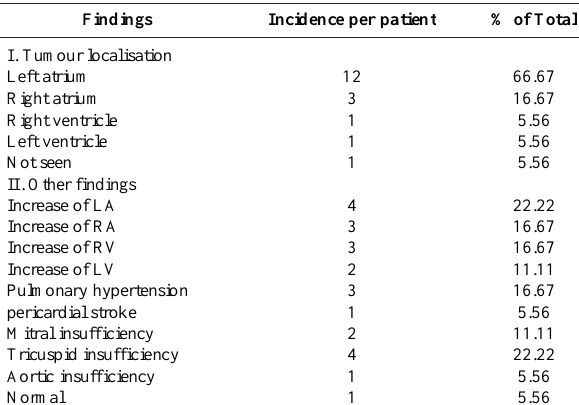
Table 5. Echocardiographic characteristics of patients with cardiac tumours.